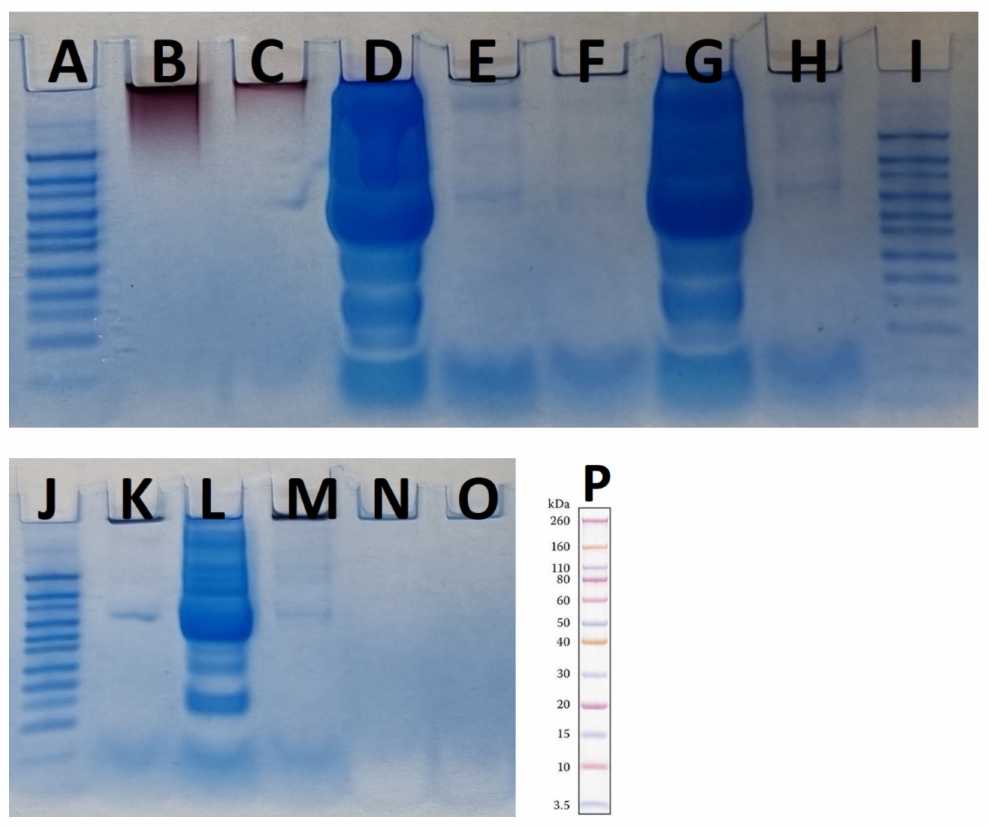
Figure 8. Two SDS-PAGE gels for different concentrations of plasma as controls and AuNPs with different concentrations of plasma as tests in the presence of MES running buffer. ( A , I , J , P ) are Novex Sharp pre-stained protein standard. ( B ) “hot” AuNPs, ( C ) “cold” AuNPs, ( D ) plasma 55%, ( E ) “hot” AuNPs—plasma 55%, ( F ) “cold” AuNPs—plasma 55%, ( G ) plasma 25%, ( H ) “hot” AuNPs—plasma 25%, ( K ) “cold” AuNPs—plasma 25%, ( L ) plasma 10%, ( M ) “hot” AuNPs—plasma 10%, ( N ) “cold” AuNPs—plasma 10%, and ( O ) LDS sample buffer as